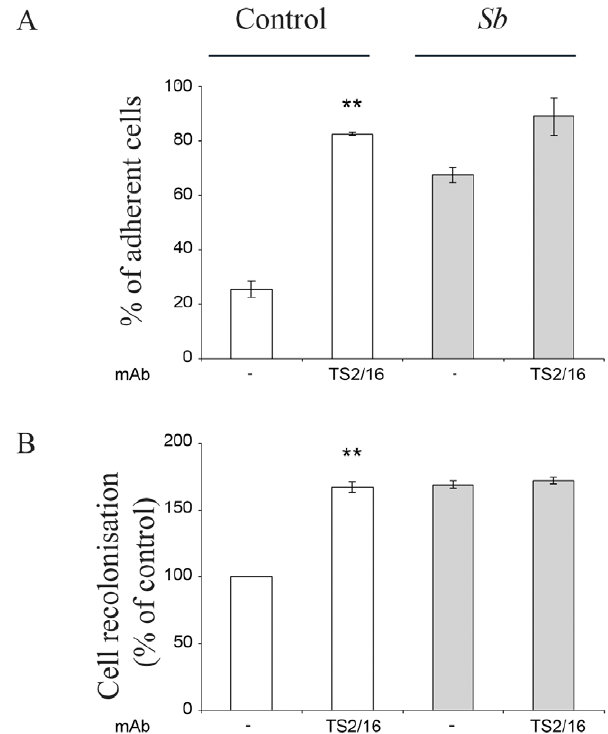
Figure 8. Sb modulates integrin activation state. HCT-8/E11 cells were incubated with or without Sb supernatant in the absence ( 2 ) or the presence of a b 1 integrin-activating mAb (TS2/16) ( A ). Cells were allowed to adhere to 3 m g/ml type I collagen for 30 minutes. Cell adhesion was evaluated as described in Methods. ** P , .01. ( B ) Cells were allowed to migrate as described in Methods. Results are expressed as the percentage of cell migration compared to control. Data represent the mean 6 SD of 3 separate experiments. ** P ,